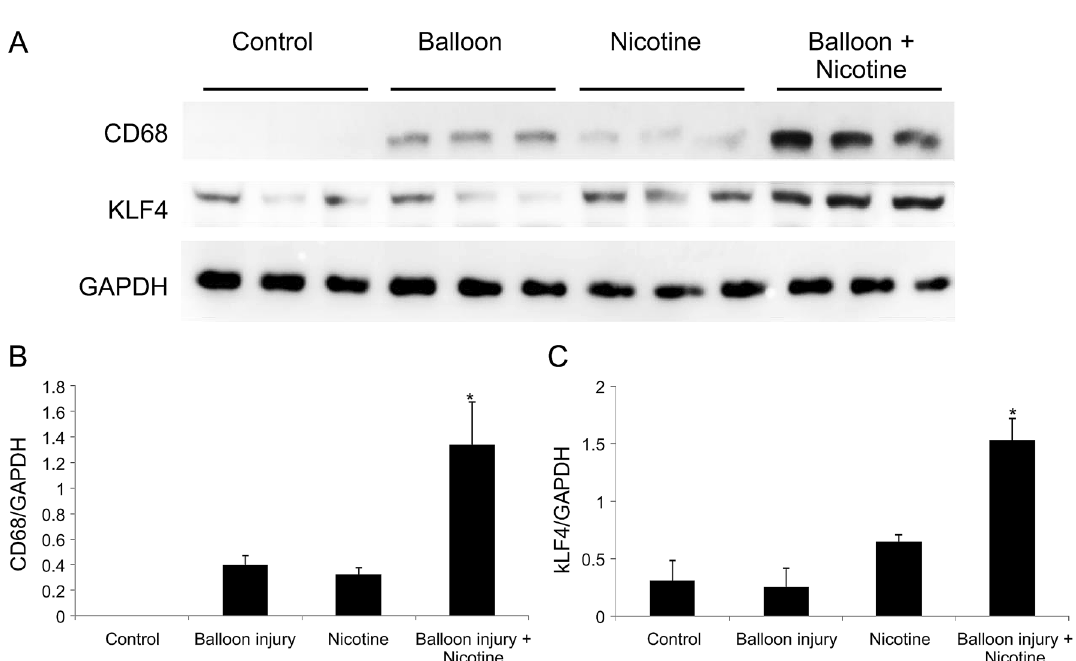
Figure 3. Increased expression of Krüppel-like factor 4 (KLF4) and cluster of differentiation 68 (CD68) in the nicotine injection with balloon overdilation groups. ( A ) Western blot analysis was performed to identify the changes in KLF4 and CD68 expression. ( B ) In the control groups, CD68 was not expressed in the coronary arteries. Balloon overdilation or nicotine injection increased CD68 expression. The nicotine injection with balloon overdilation groups had significantly increased CD68 expression compared to the other groups. ( C ) KLF4 expression was similar in the control and balloon overdilation groups and nicotine injection increased KLF4 expression. Nicotine injection with balloon overdilation significantly increased KLF4 expression in the coronary arteries. * P <